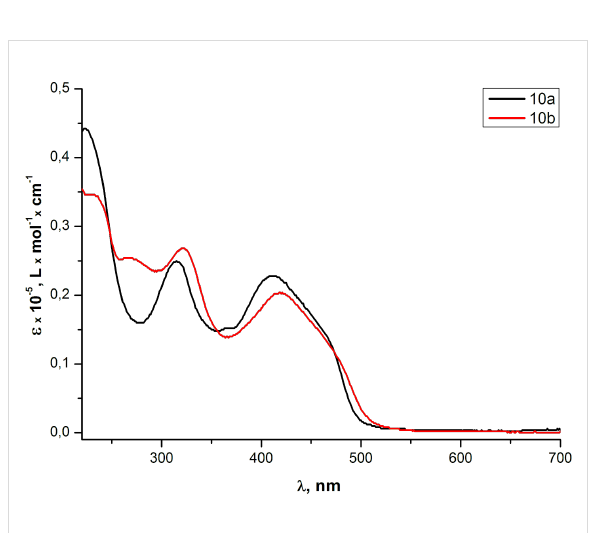
Figure 5: Irregular chain structure (nonequivalent structural units are marked in different colors).